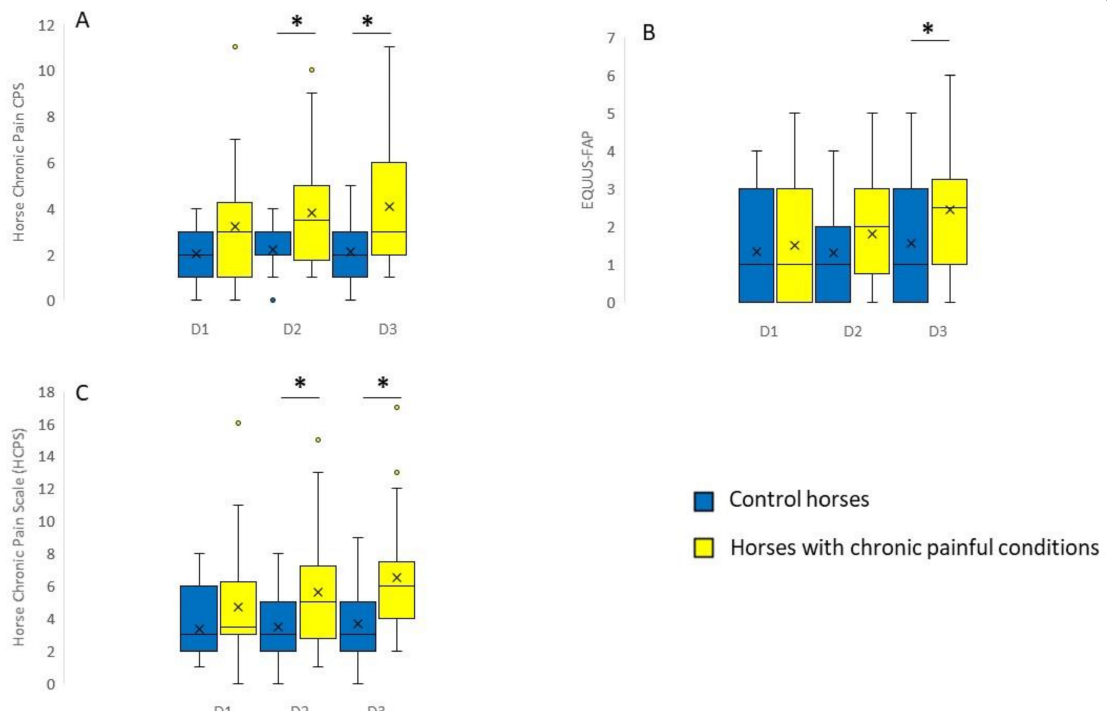
Figure 2. Composite and facial expression-based pain scales in horses with chronically painful conditions and healthy control animals. ( A ) Horse Chronic Pain Composite Pain Scale (HCP CPS). ( B ) Equine Utrecht University Scale for Facial Assessment of Pain (EQUUS-FAP). ( C ) Horse Chronic Pain Scale (HCPS; combination of HCP CPS and EQUUS-FAP). D1, Day 1; D2, Day 2; D3, Day 3. Boxes show 25–75 percentiles, with the horizontal line being the median and the x being the mean score; whiskers show 5–95 percentiles; open dots show outliers. * p < 0.05 ( n = 27 control animals; n = 26 horses with chronic painful conditions).